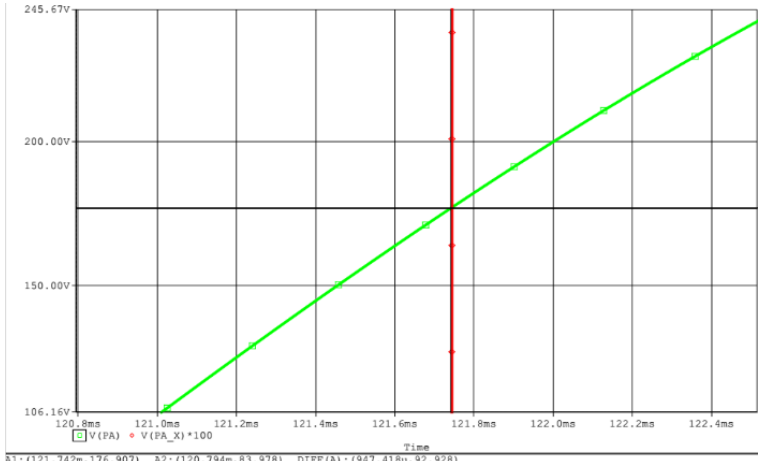
Figure 27. Modified line frequency circuit simulation.